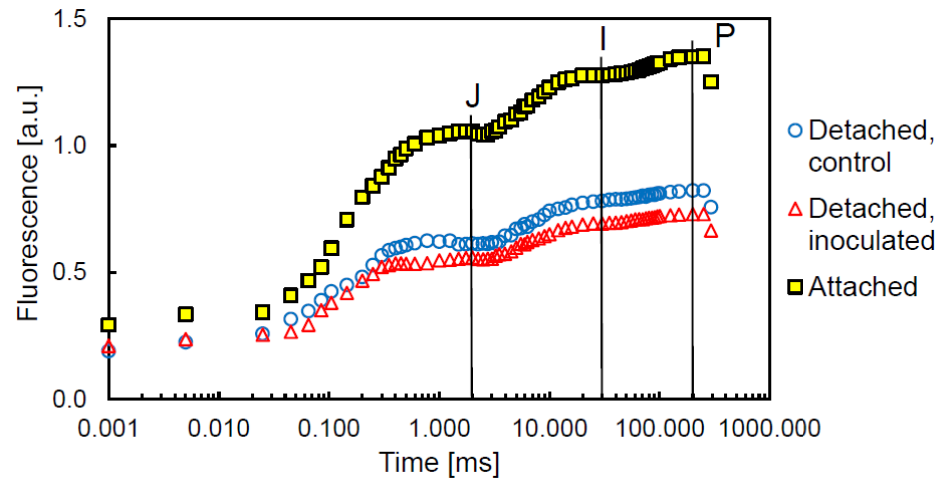
Figure 3. Fast Chl a fluorescence transient (‘JIP’ curve) of dark-adapted tobacco leaves at c. 10,000 µmol m − 1 s − 1 . Minimum fluorescence (F 0 ) was taken at the onset of fluorescence induction (t = 0), but is indicated in the figure for convenience at t = 0.001. The three curves of detached control and inoculated leaves, as well as attached leaves, represent the mean values of all measured leaves. The ‘J’ step was set at 2.0 ms, the ‘I’ step at 30 ms, and the ‘P’ step (or F m ) was taken at 200 ms. Table 3. Chl-fluorescence parameters derived from measurements of the fast Chl a transient of tobacco leaves inoculated with Pto DC3000 compared to control leaves.